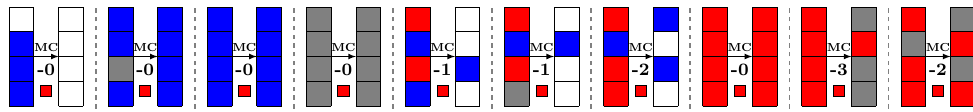
Figure 13: Some valid coloring schemes of MC + -RULE [BDG +